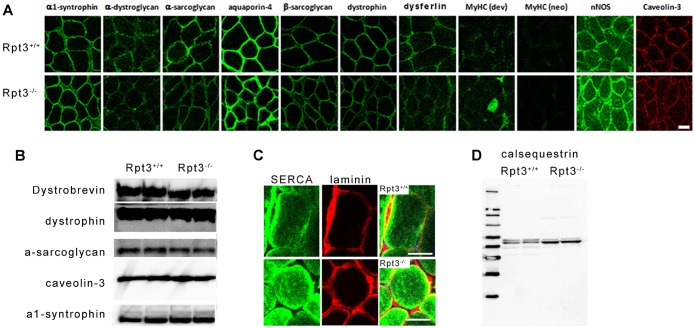
Immunohistochemistry and immunoblotting of the dystrophin glycoprotein complex and sarcoplasmic reticulum proteins in the gastrocnemius of Rpt3−/− and Rpt3+/+ mice. (A,B) Immunohistochemistry and immunoblotting of the components of the dystrophin glycoprotein complex in 6-week-old mice. No apparent differences were observed in α1-syntrophin, α-dystroglycan, α-sarcoglycan, aquaporin-4, β-sarcoglycan, dystrophin, dysferlin, neuronal nitric oxide synthetase or caveolin-3 levels. A small amount of developmental myosin heavy chain was observed in muscles from Rpt3−/− mice. Neonatal myosin heavy chain was not observed. Scale bar: 50 µm. (C,D) Immunohistochemistry and immunoblotting to detect the sarcoplasmic-reticulum-related proteins SERCA1 (C) and calsequestrin (D).